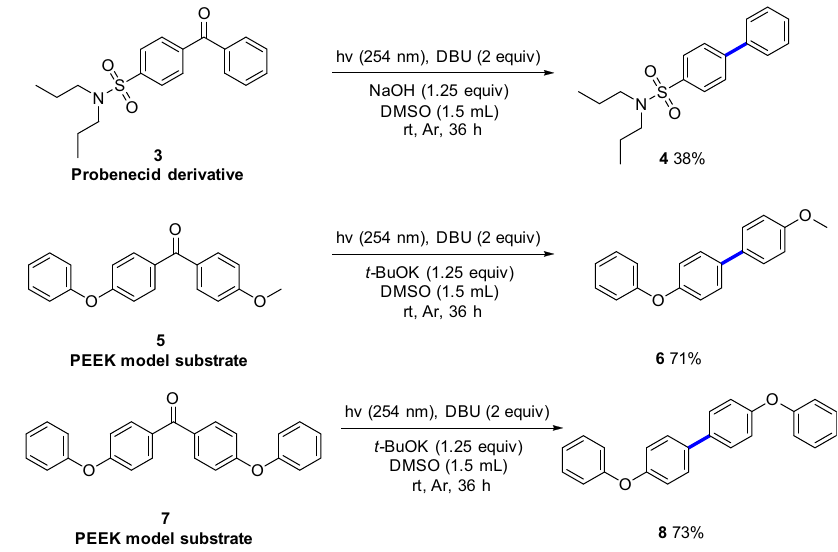
Fig. 3 Applications. Conversion of probenecid derivative and polyetheretherketone (PEEK) model